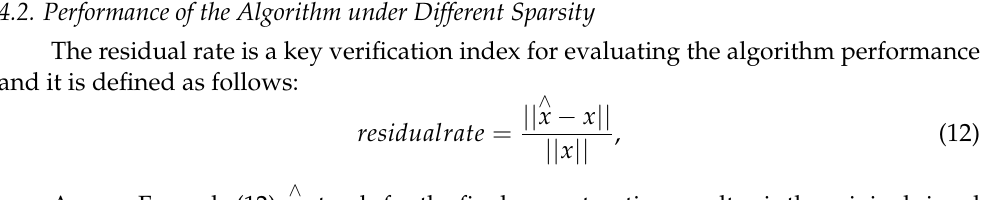
Figure 6. Signal reconstruction diagram. ( a ) Original signal; ( b ) the reconstructed signal.